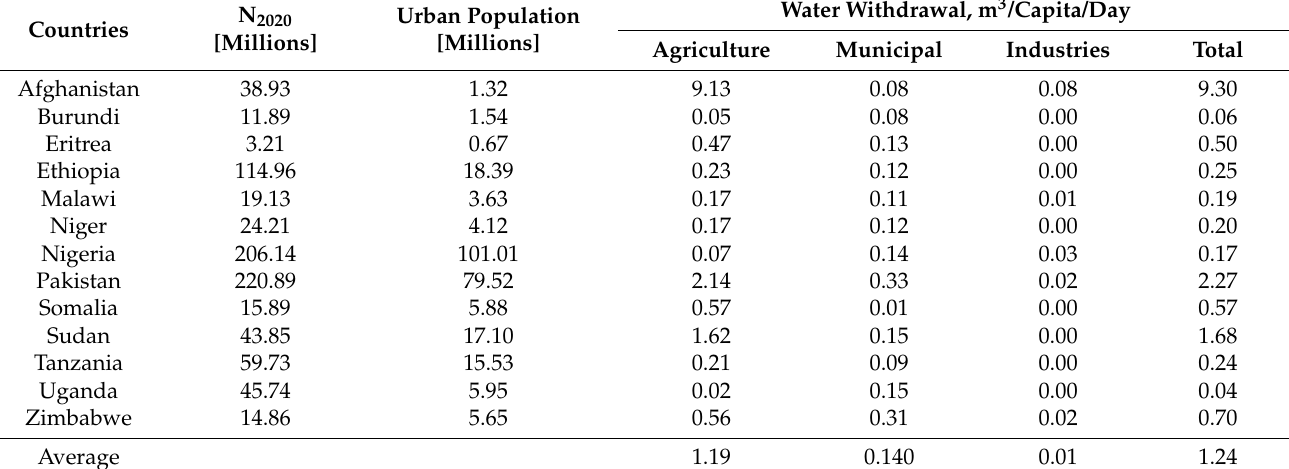
Table 2. Water withdrawal in each water-scarce country